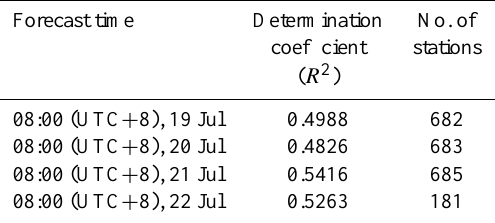
Table 2. Correlation of daily PLAM/h index 24h forecasts and vis- ibility during the whole period of the regional heavy fog-haze event over North China during 19–22 July 2013. Forecast